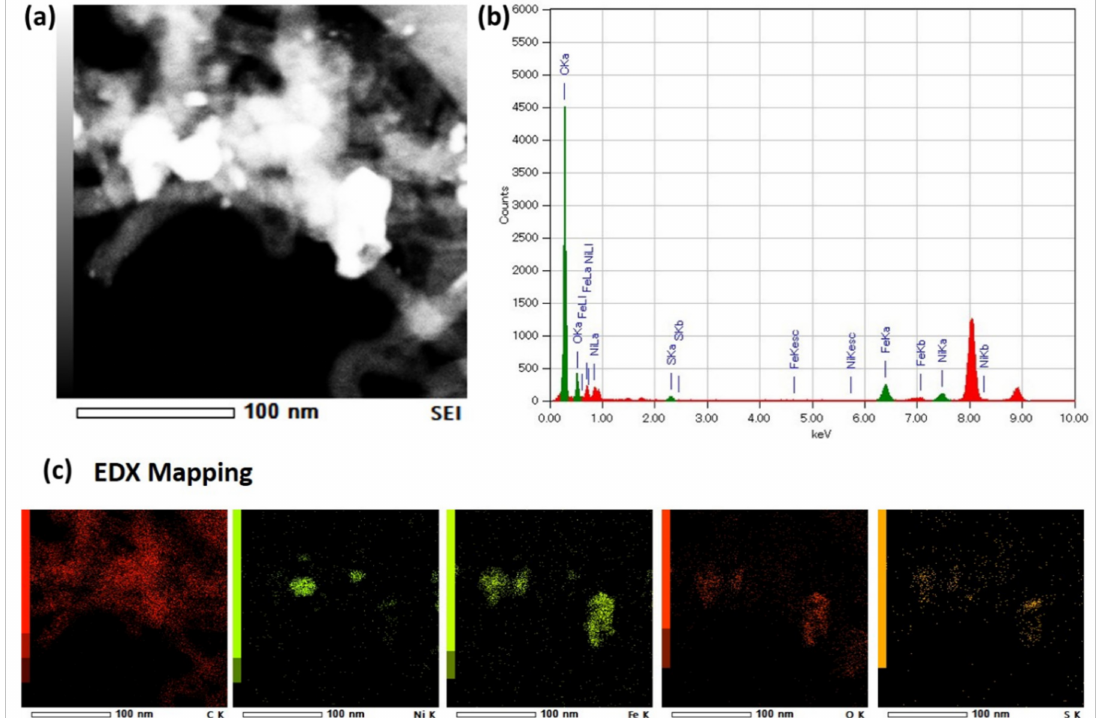
Figure 14. Scanning transmission electron microscopy (STEM) image in the selected area of the CNTs. ( a ) Bright-field image, ( b ) corresponding EDX spectra, and ( c ) EDX element distribution